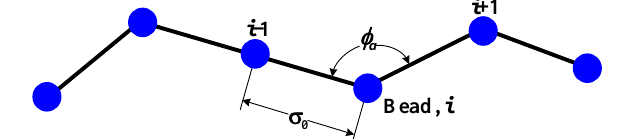
Figure 2. Polymer chain model used in this study for discretization of dsDNA